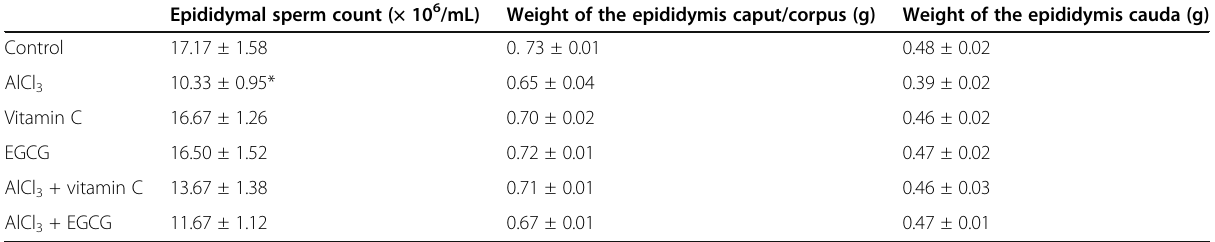
Table 3 Effect of EGCG on sperm count and weight of the epididymis caput and epididymis cauda in SD rats Epididymal sperm count (× 10 6